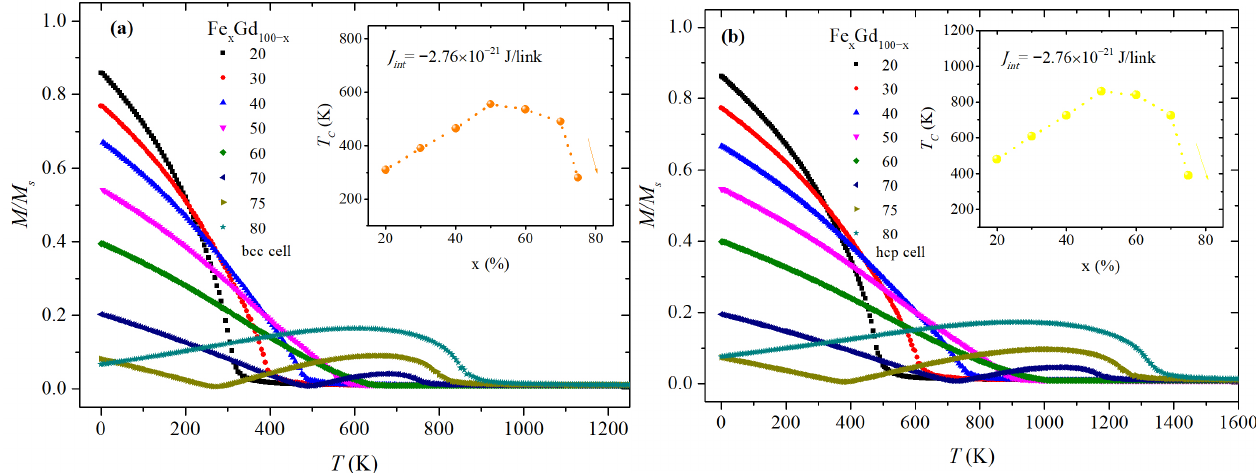
Figure 4. Simulations of temperature-dependent normalized magnetization of the Fe x Gd 100 − x alloys with antiferromagnetic exchange interactions for the bcc ( a ) and hcp ( b ) structures for the value of exchange interaction J Fe − Gd = − 2.760 × 10 − 21 J/link. The insets of the figures show the concentration dependence of the critical temperature, determined from the corresponding M(T) curves.